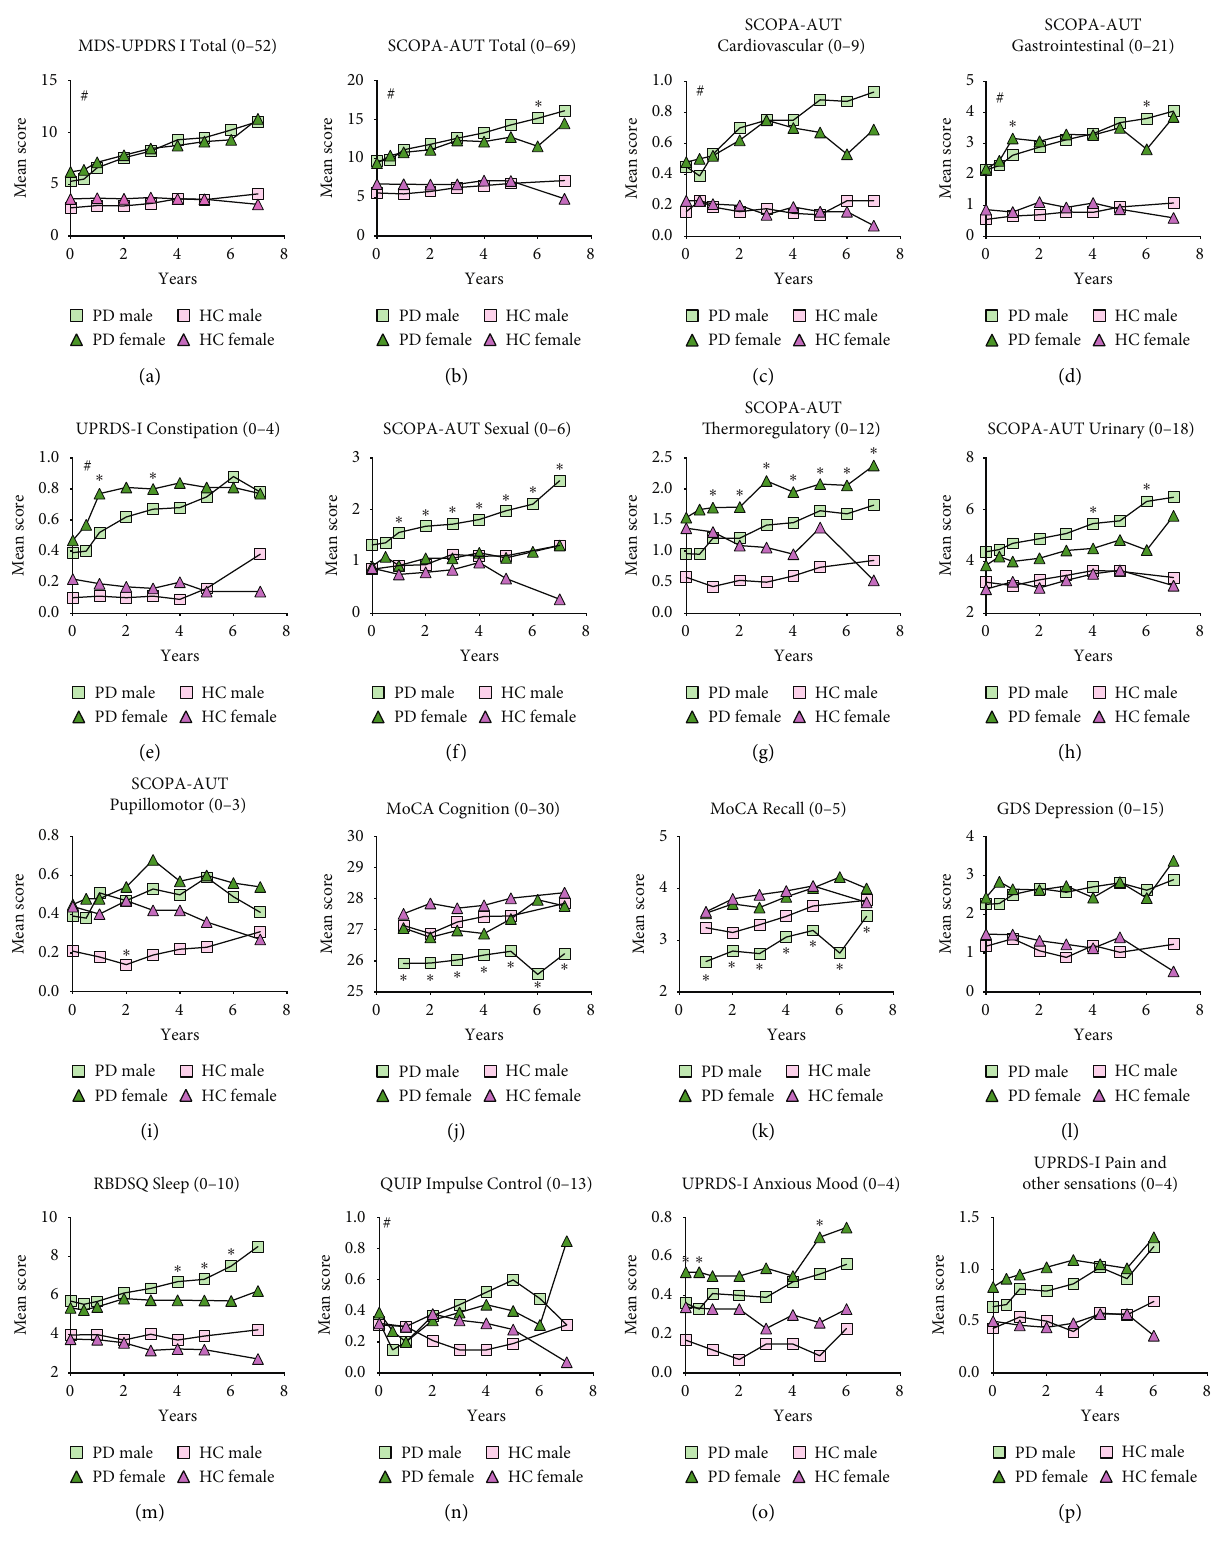
Figure 2: Progression of NMS in PD cohort categorized by sex. NMS mean scores were categorized by sex of patient (female (F) or male (M)) for Parkinson’s disease (PD) and healthy controls (HC). NMS scales analyzed are displayed A through P indicating the score range in the title of individual graphs. Higher number indicates more dysfunction except for MoCA Cognition (J). Differences in mean scores within PD and HC cohorts (females vs. males) were evaluated using two-way ANOVA with multiple comparisons for each time point. Statistically significant differences within cohorts (F vs. M) are indicated by an asterisk ∗ . Statistically significant ANOVA interaction of time and cohort on NMS scale are indicated by # p < 0 .